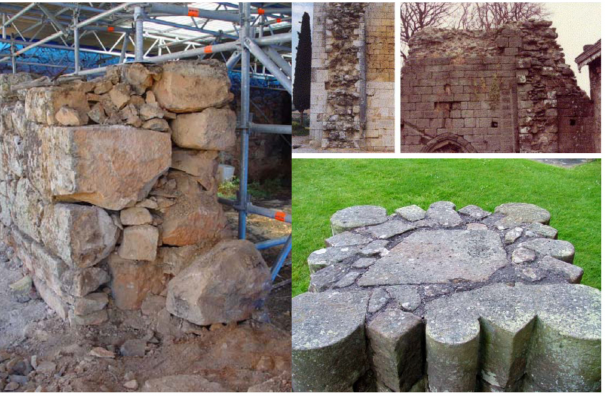
Figure 1. Examples of ancient masonry section with complex arrangements of units.